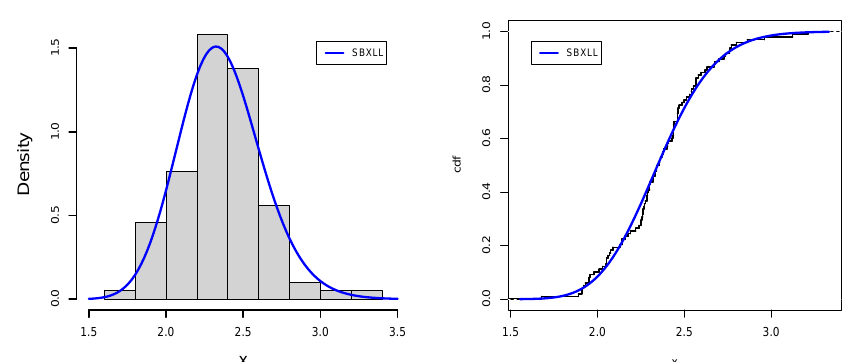
Figure 9. Plots of estimated pdf and cdf of the SBXLL model for data set-III.